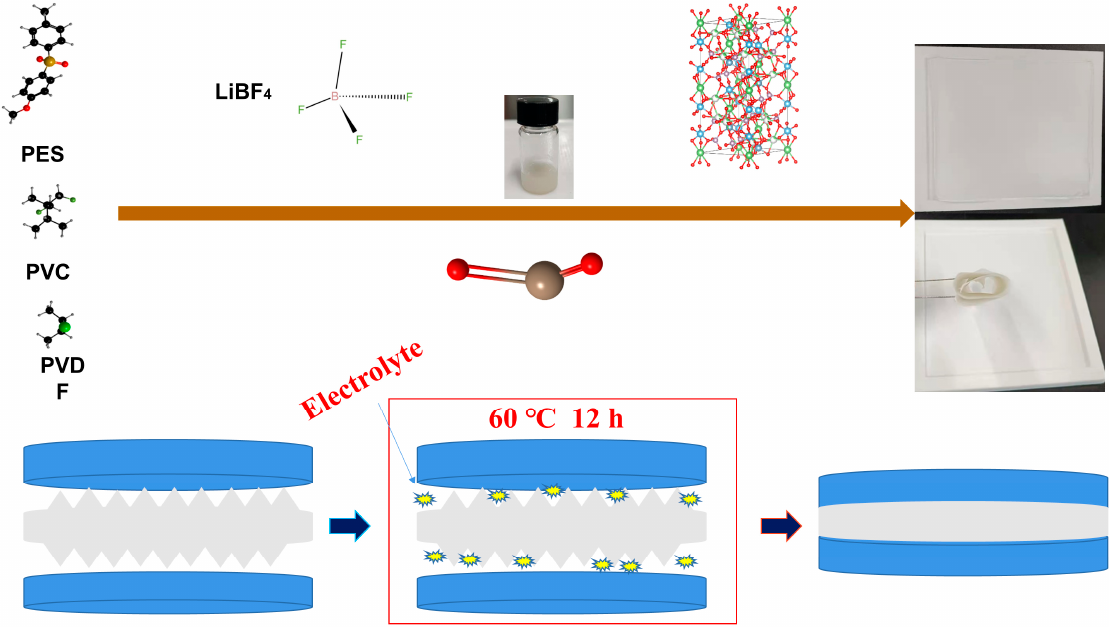
Figure 3. Schematic diagram of preparation of PES-PVC-PVD-LiBF 4 -LATP polymer electrolyte and assembly of solid-state LiNi 0.5 Mn 1.5 O 4 /SPLL/Li lithium battery.